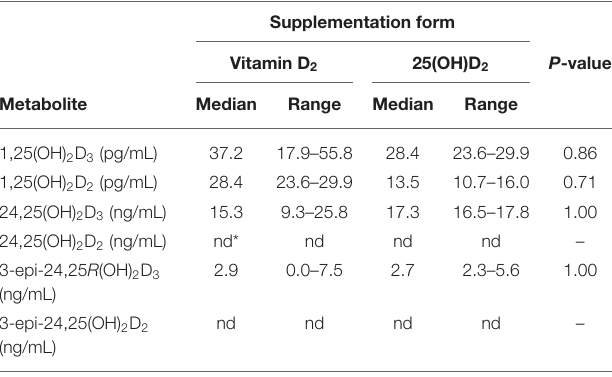
TABLE 2 | Median and range values of plasma vitamin D metabolites in cats after 10 weeks of oral supplementation with vitamin D 2 ( n = 4) or 25(OH)D 2 ( n = 3) while consuming a commercial feline diet containing vitamin D 3